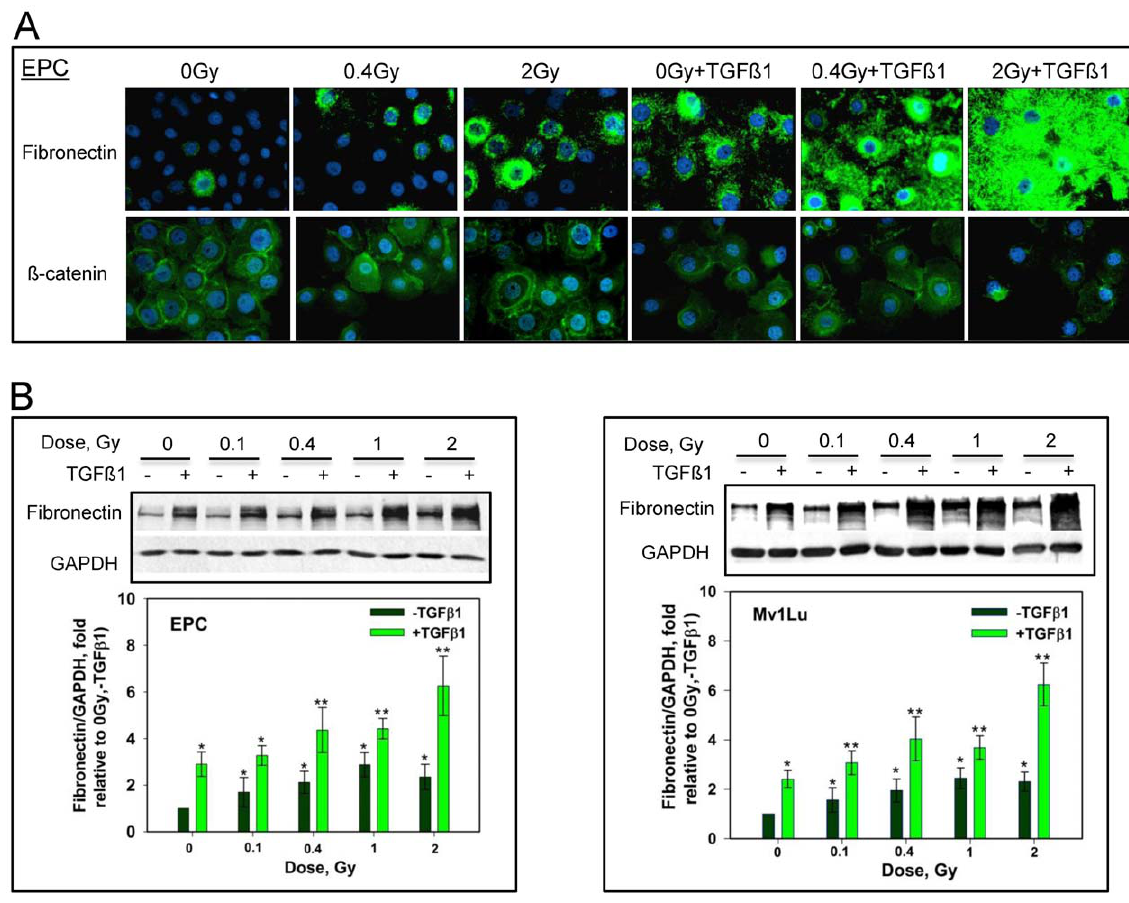
Figure 4. Protons can enhance TGF b 1 induced EMT-like changes in both EPC and Mv1Lu cells in a dose-dependent manner. A. Immunostaining with fibronectin and b -catenin in EPC cells upon TGF b 1 stimulation post exposures to different doses of protons. B. Effect of radiation doses on the expression of fibronectin in the presence of TGF b 1 in EPC cells (left panel) and Mv1Lu cells (right panel). Whole cell extracts prepared by M-PER were used for western blotting. Other details were shown in Figure 1. Plotted are the expression levels of fibronectin vs. GAPDH and relative to controls (0 Gy, -TGF b 1). Two protons exposures with three gels each for a total of six western blots were analyzed. Error bars indicate standard deviations. Single asterisks indicate that fibronectin/GAPDH is highly significantly difference (p-value , 0.01) compared to 0 Gy un-treated cells. Double asterisks indicate that there is a highly significant difference compared to 0 Gy + TGF b 1 (p-value , 0.01).